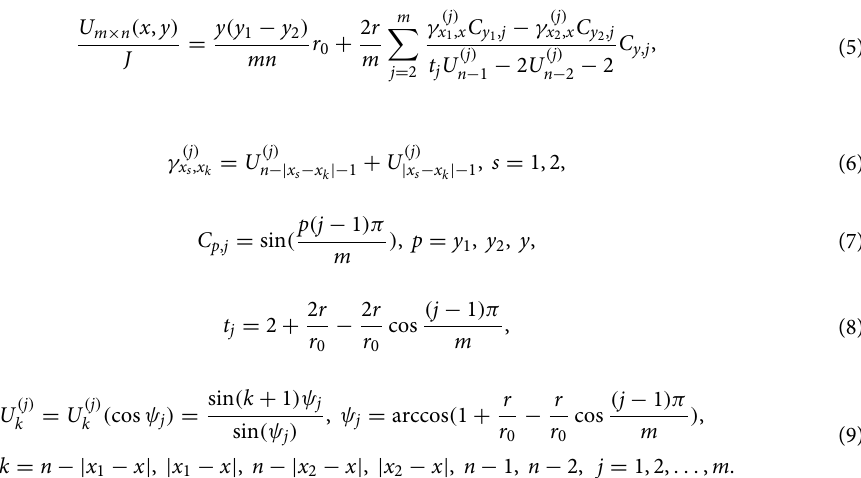
90 ( x , y )/ J with the current input and output point ×